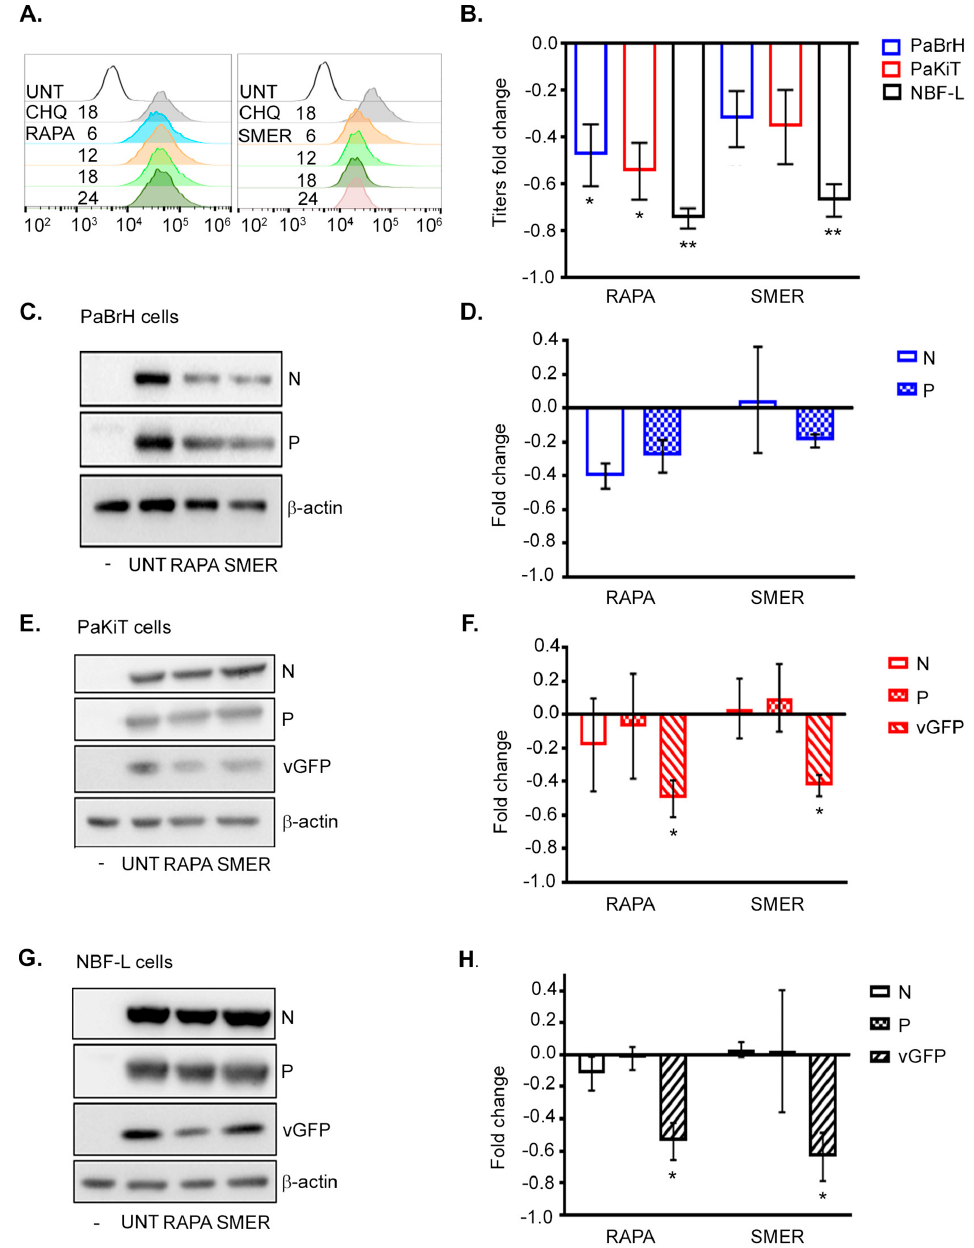
Figure 6. Pharmacologic activation of autophagy limits ABLV replication. ( A ) Flow cytometry histogram overlays of PaKiT cells stained with CYTO-ID ® . PaKiT cells were treated with RAPA (2 µM), and SMER (50 µM) for h indicated; as well as CHQ (1 µM, 18 h). ( B ) Fold change in rABLV-GFP titers (pfu/mL) fold change from PaBrH, PaKiT, and NBF-L cell culture supernatants collected 48 hpi (MOI 1.0). Cells were treated with RAPA (2 µM) and SMER (50 µM) for 24 h. ( C ) Western blot of ABLV N, P, and vGFP in PaBrH cell lysates. ( D ) Fold change in ABLV N, P, and vGFP proteins ( β -actin-normalized) from PaBrH cell lysates. ( E ) Western blot of ABLV N, P, and vGFP collected in PaKiT cell lysates. ( F ) Fold change in ABLV N, P, and vGFP proteins ( β -actin-normalized) collected from PaKiT cell lysates. ( G ) Western blot of ABLV N, P, and vGFP collected in NBF-L cell lysates. ( H ) Fold change in ABLV N, P, and vGFP proteins ( β -actin-normalized) collected from NBF-L cell lysates. ( C – H ) Whole cell lysates were collected 48 hpi (rABLV-GFP MOI 1.0). Fold change is a representation of at least three independent experiments, mean ± SEM and ** p < 0.001, * p < 0.05 ANOVA (one-way) analysis, Dunnett’s multiple comparison test with treatments compared to DMSO mock treated